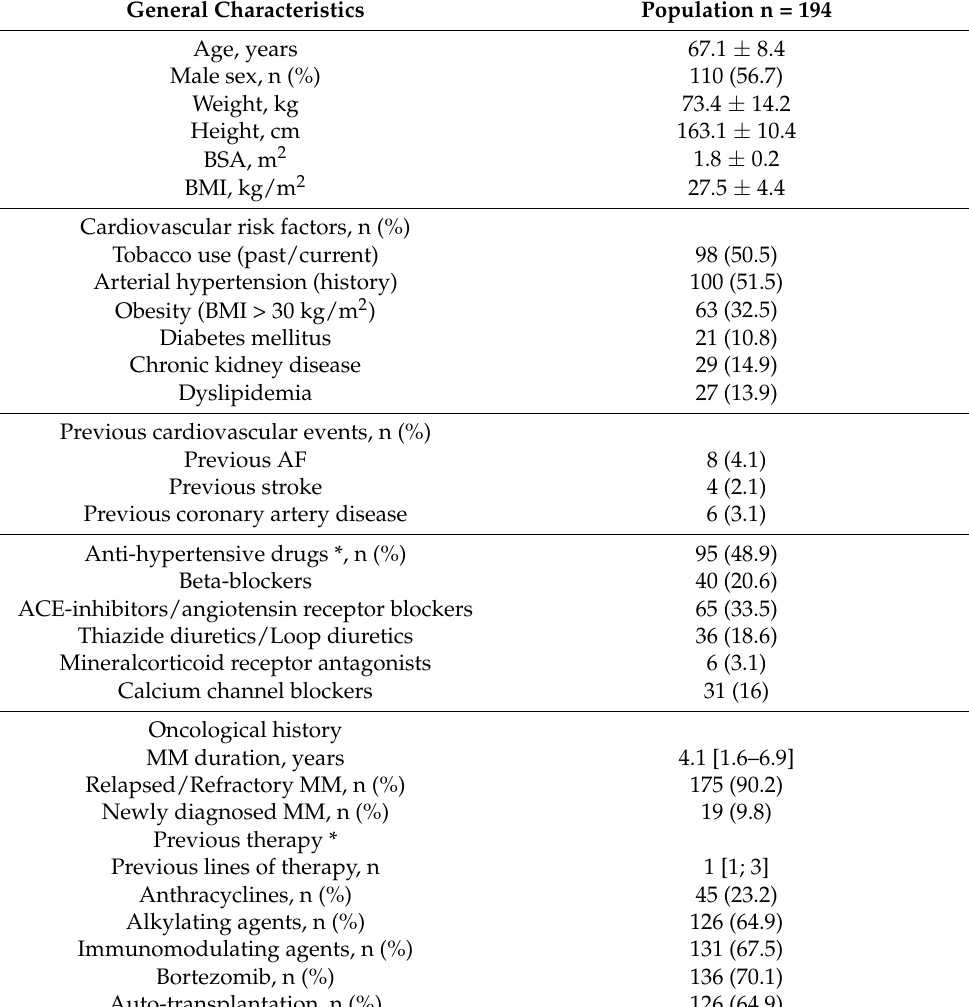
Table 1. General and clinical characteristics of the population at